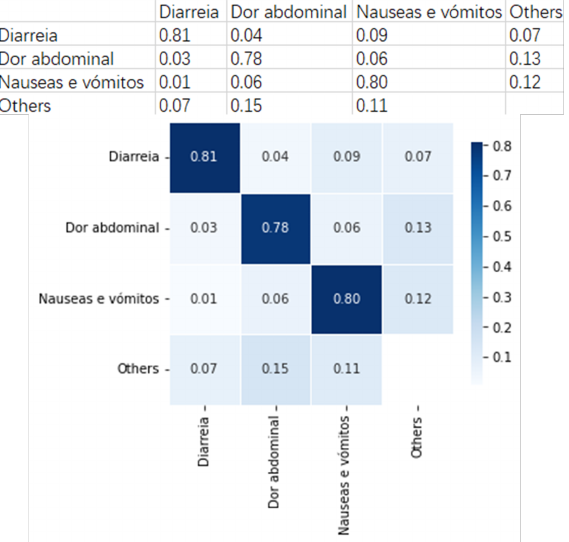
Figure 10. Analysis among clinical pathways with similar clinical symptoms using the trained neural network model. This group includes three clinical pathways: Diarreia ( Diarrhea ), Dor abdominal ( Abdominal pain ), and Náuseas e vômitos ( Nausea and vomiting